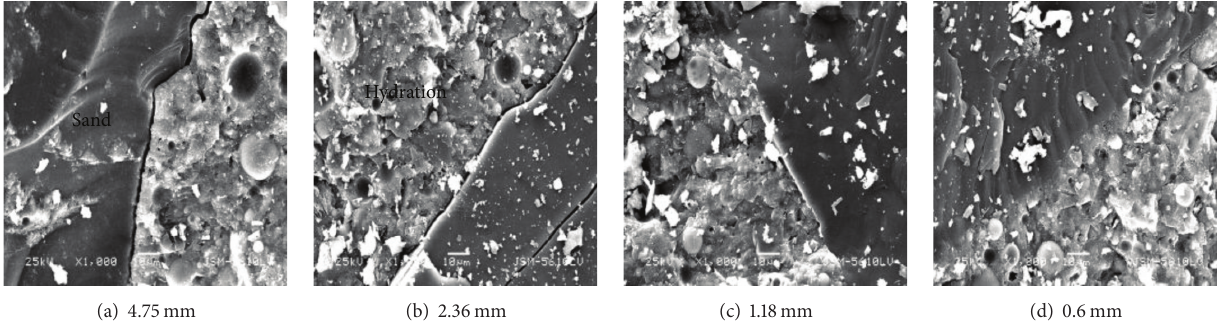
Figure 5: SEM of interfacial transition zone × 1000.